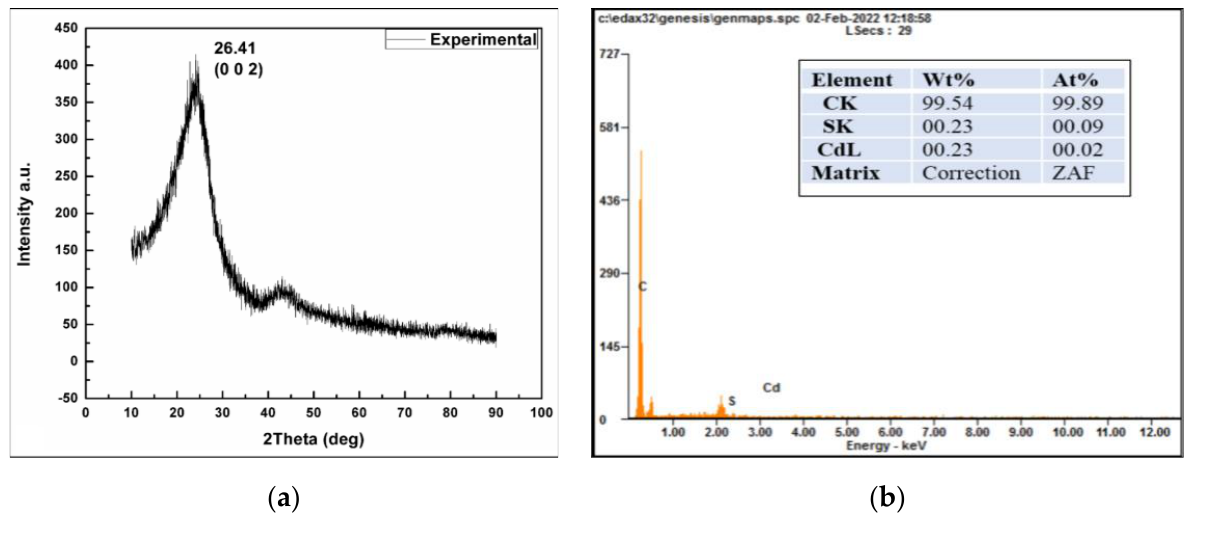
Figure 6. ( a ) X-ray diffraction pattern; ( b ) EDX spectrum of A. squamosa CDs.